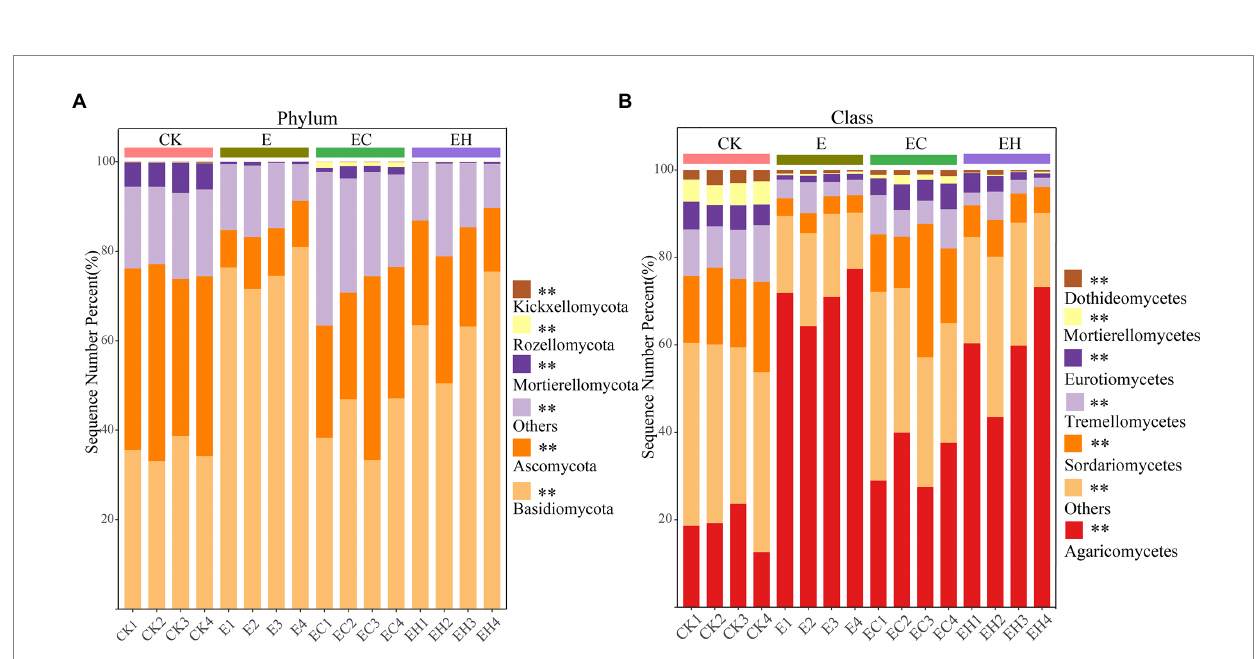
FIGURE 3 Soil fungal community composition at phylum (A) and class (B) level in pure eucalypt plantations (CK, E) and mixed plantations (EC, EH). * represents significant differences in the abundance of fungal taxa within different types of plantations. CK, the first rotation of E. urophylla plantations; E, the third rotation of E. urograndis plantations; EC, mixed plantations of E. urograndis and Cinnamomum camphora ; EH, E. urograndis and Castanopsis hystrix